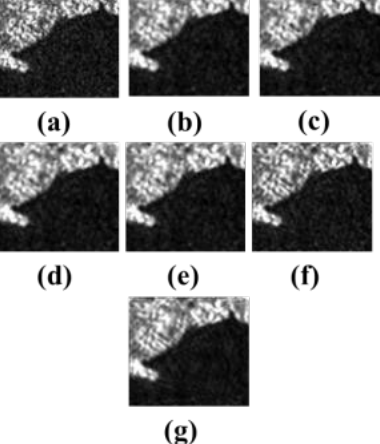
Figure. 2: Despeckling results of different filters for RADARSAT image: (a) Airsar Image, (b) Frost, (c) Gamma, (d) Kuan, (e) Lee, (f) K-sigma, (g) Proposed method.